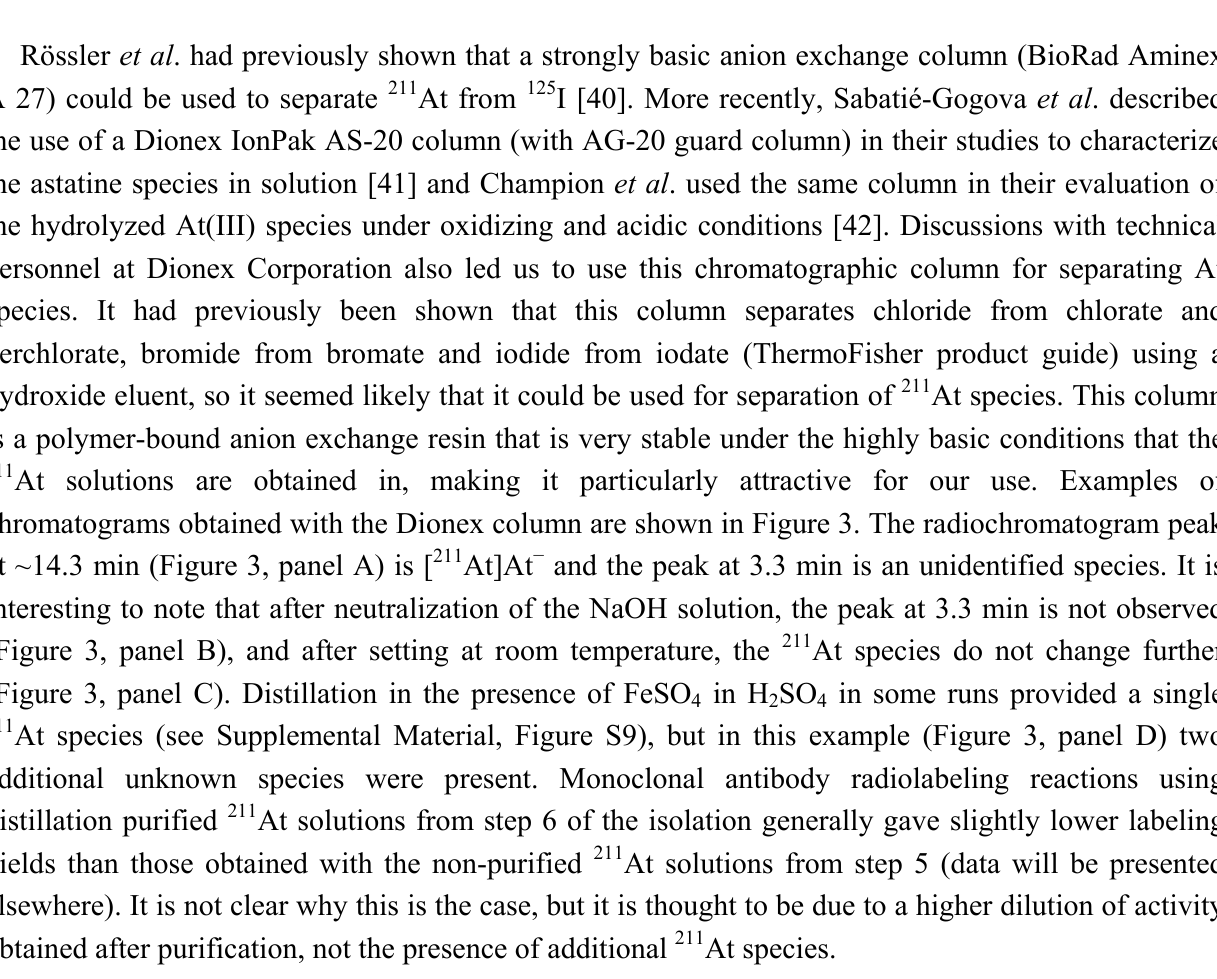
Figure 3. Radiochromatograms obtained by eluting 211 At solutions on a Dionex IonPac AS20 column using isocratic conditions with 50 mM NaOH @ 1